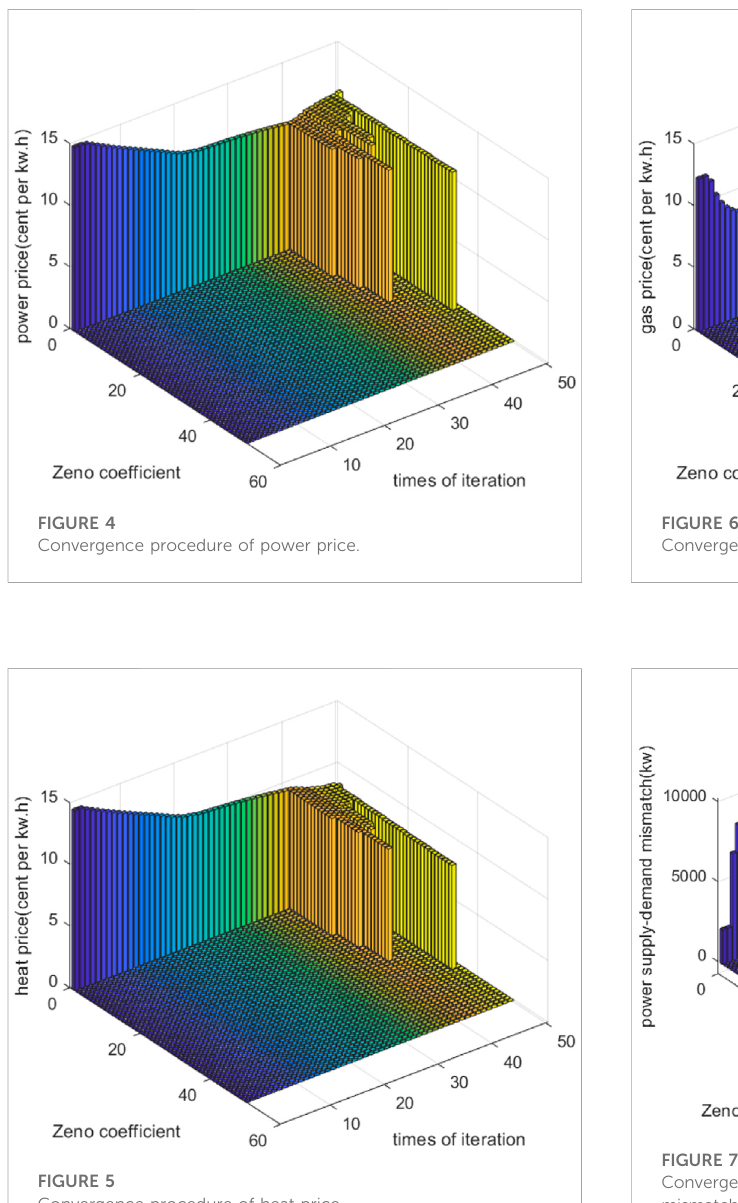
FIGURE 7 Convergence procedure of power supply-demand